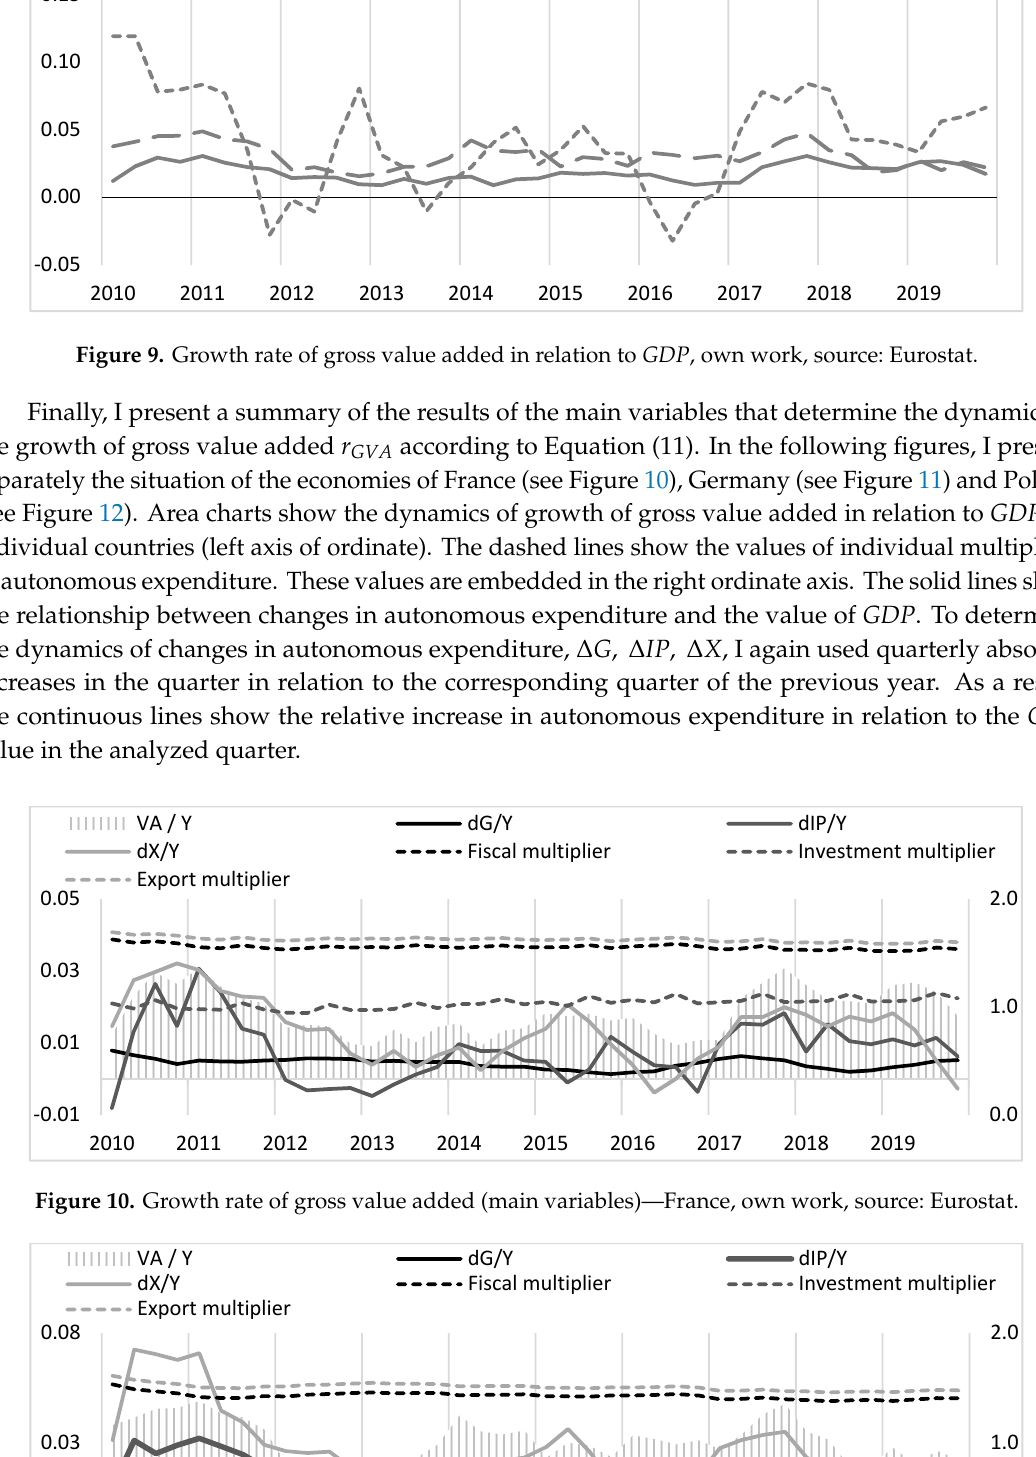
Figure 11. Growth rate of gross value added (main variables)—Germany, own work, source: Eurostat. Figure 12. Growth rate of gross value added (main variables)—Poland, own work, source: Eurostat.